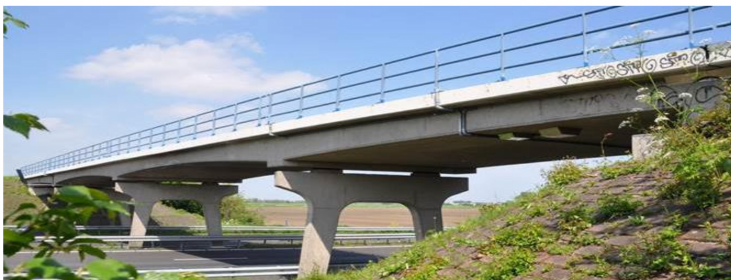
Figure 3. Example of a common four-span plate bridge type in the Netherlands: Bridge Zijlweg of the highway A59 in the province Brabant.